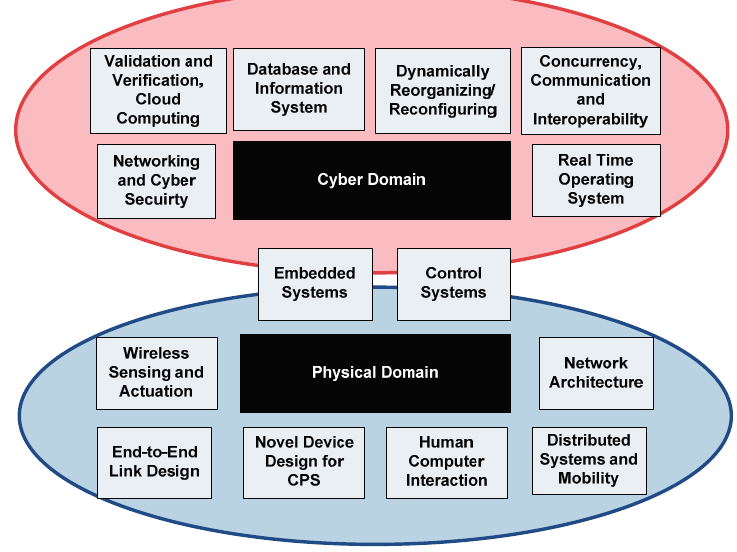
Figure 6. A division of cyber-physical sensor network